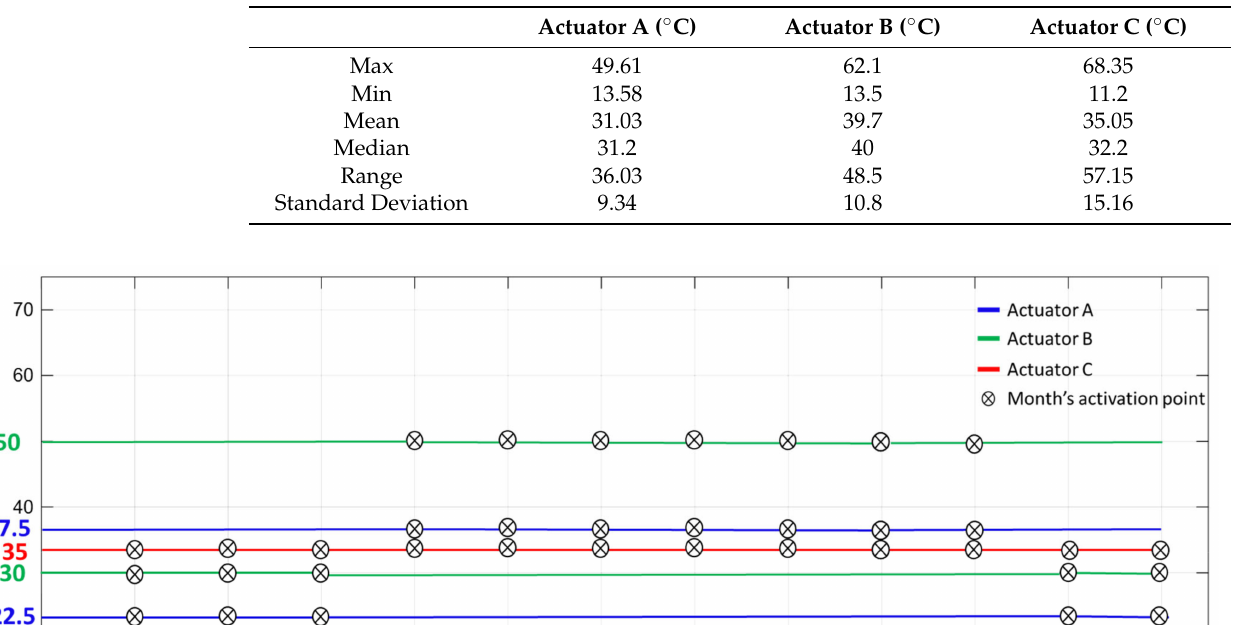
Table 2. Statistical data for the temperature inside the SHC over one year.